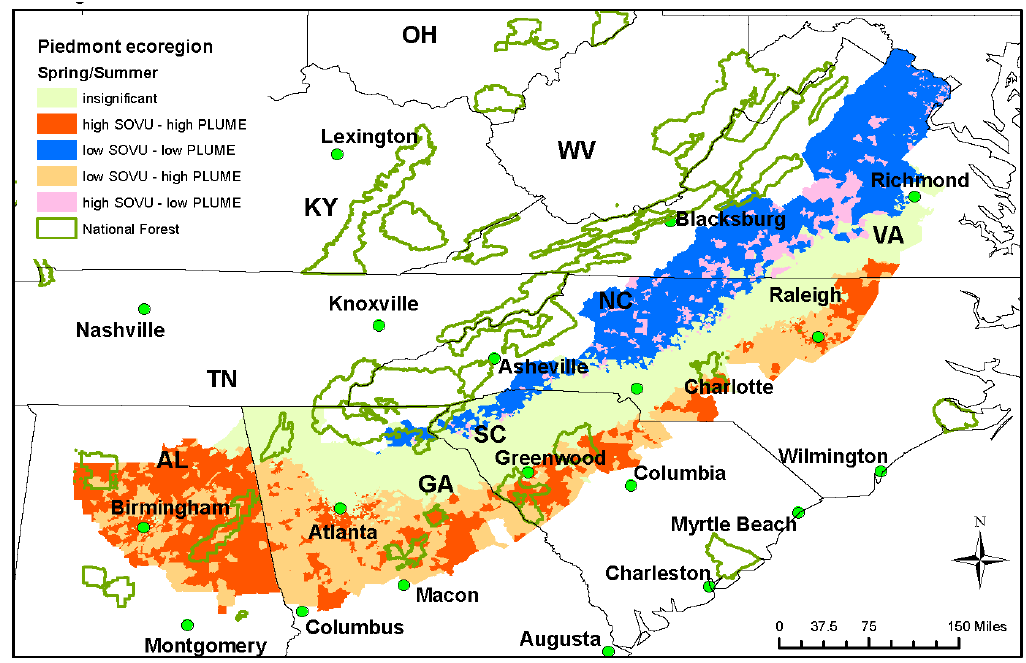
Figure 7. Bivariate LISA mapping of social vulnerability and smoke plume in the Piedmont